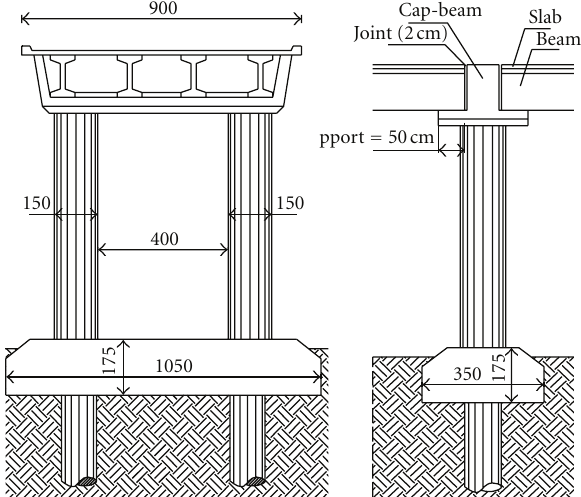
Figure 3: Pier elevation and longitudinal